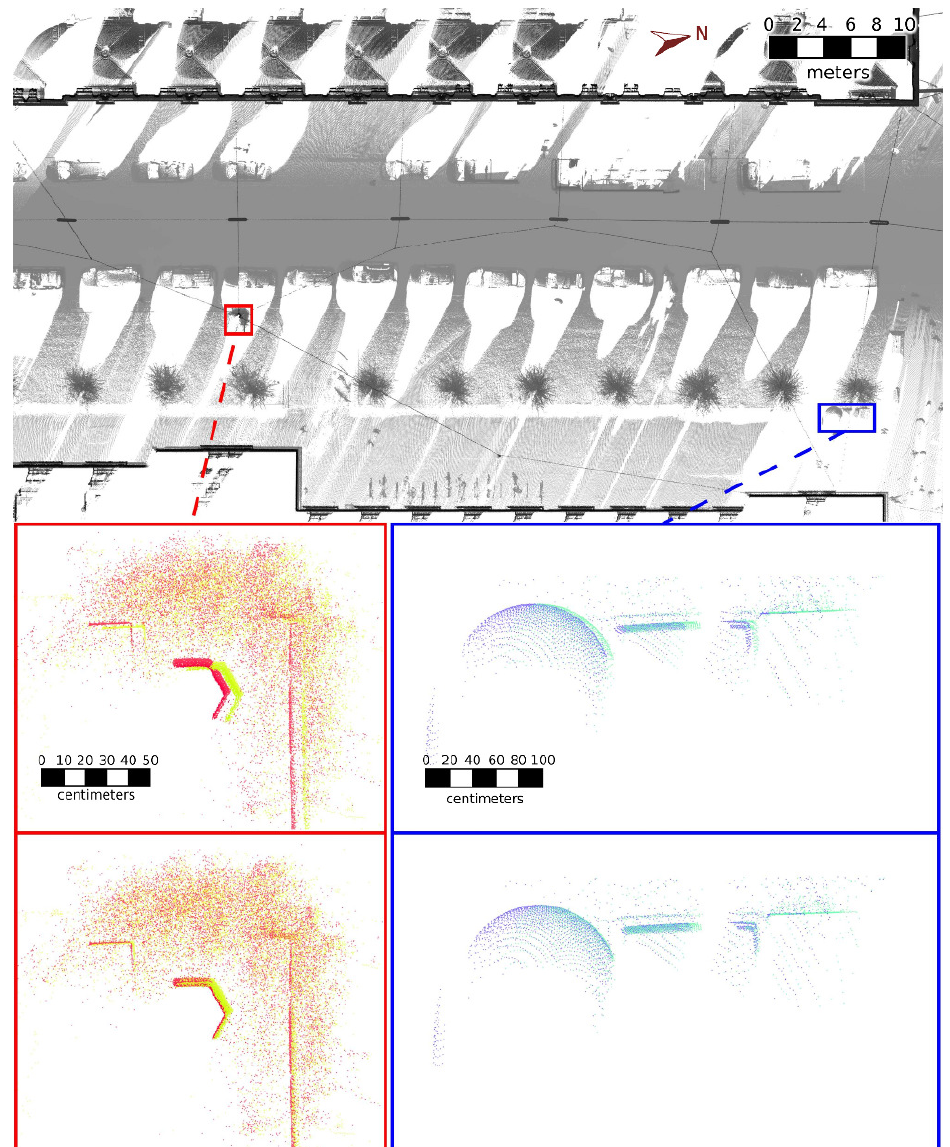
Figure 21. The Vienna dataset acquired by the Riegl VMX-450 mobile laser scanning system. Since the initial dataset is of so high a quality that no difference is visible between the initial and optimized point cloud at the scale in the top, some details have been enlarged. The points are colored by their timestamps to provide contrast. In the detailed views, the top image shows the initial point cloud, while the bottom one shows the optimized point